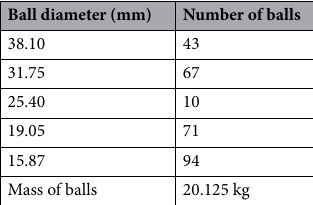
Table 2. Grinding balls used for